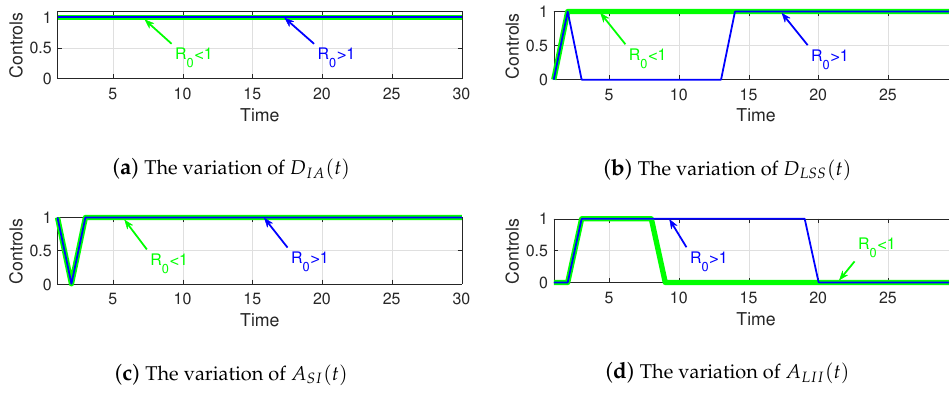
Figure 9. Variation of control